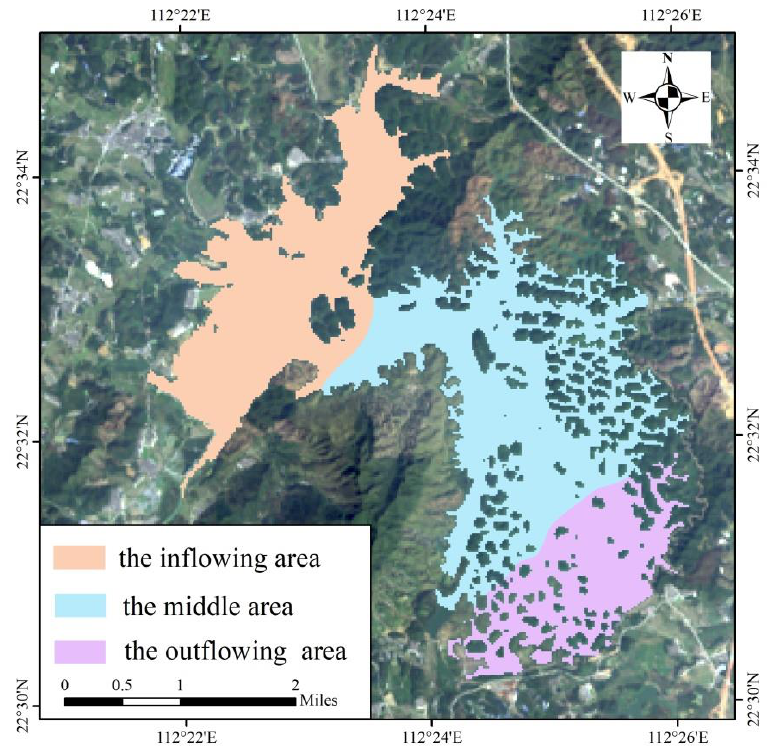
Figure 7. Evaluation area of the trophic condition in the Dashahe Reservoir.